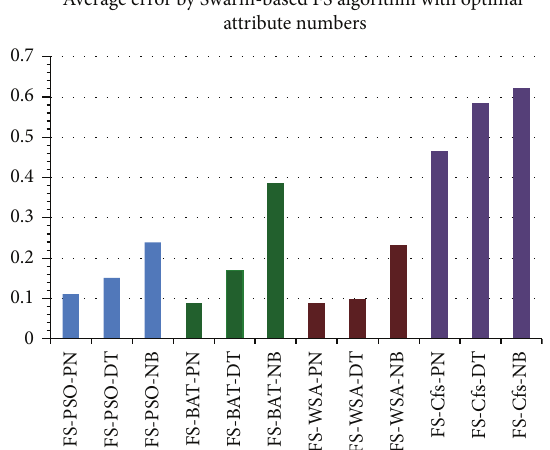
Figure 15: Comparison of different Swarm-based FS algorithms with optimal features in %